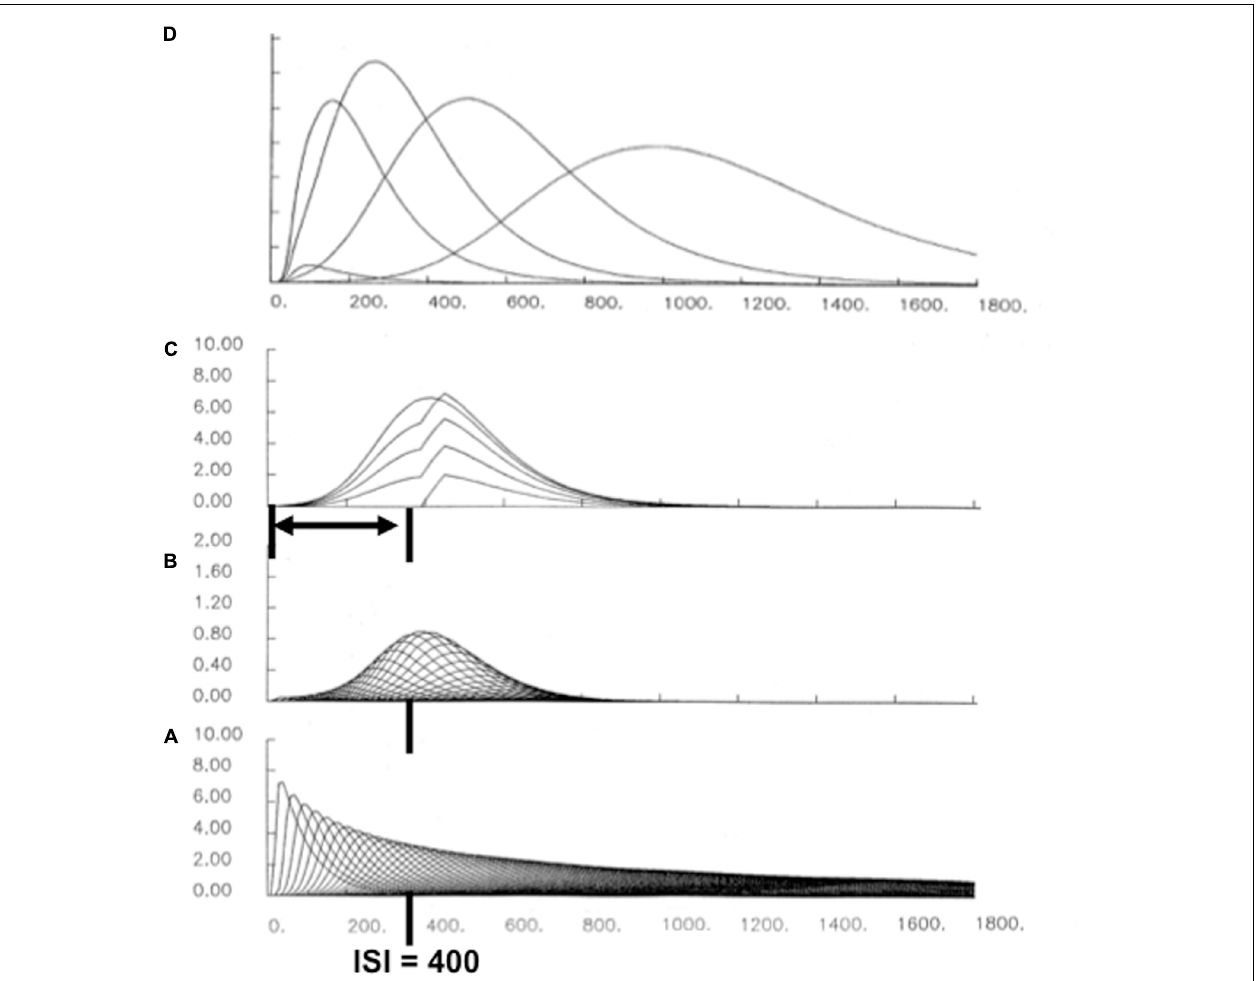
FIGURE 10 | A simulation of adaptively timed learning by a spectral timing circuit: (A) A spectrum of cells whose activities respond maximally at different times. (B) When a CS and US are paired across learning trials with an ISI of 400 ms, adaptive weights of cells that are active during that time grow proportionally to the activity of their spectral cell. When these weights are multiplied by the spectrum in (A) , the resulting learning-gated spectral signals have their largest sizes near the ISI. (C) When all the learning-gated spectral signals are added up, the population response peaks at the ISI. The superimposed curves show the growth of the timed response over the first four conditioning trials, followed by a response during recall. (D) When the population responses that are learned at different ISIs are all plotted, a Weber-law property obtains, with curves that peak later having broader curves. There is also an Inverted-U of maximal activity, with optimal conditioning occurring at an intermediate ISI, and with learning attenuated at zero and large